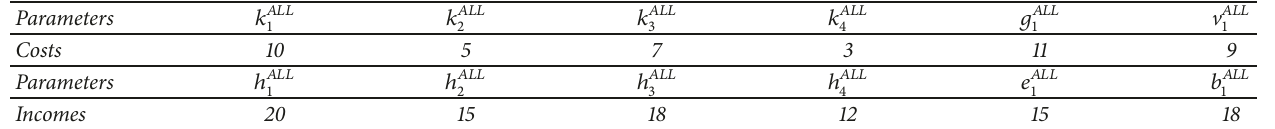
Figure 4: Demonstration of the proposed dynamic DEA on the considered case study. Table 8: Costs and incomes associated with inputs, outputs and relationships.